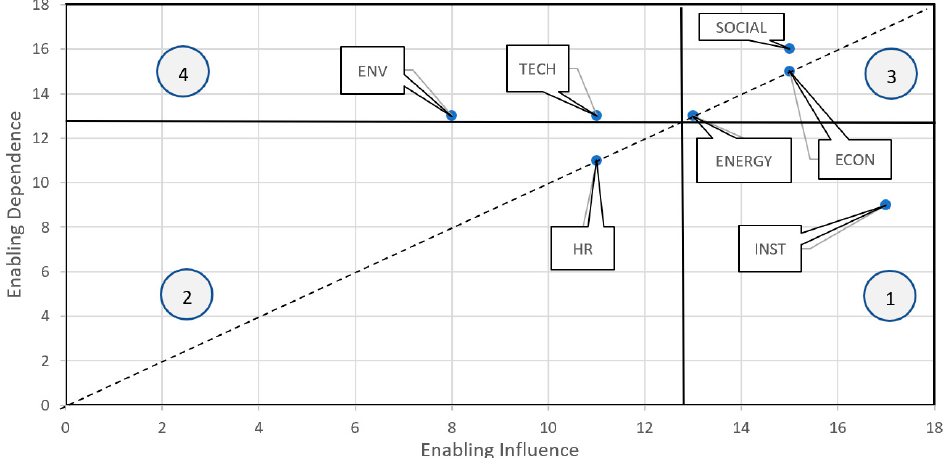
Figure 2. Graph showing the values of the degrees of direct net influence and dependence for all seven categories of capacity: INST (institutional); HR (human resources); TECH (Technical); ECON (Economic); ENERGY; ENV (Environmental); SOCIAL (social/cultural). The graph consists of four sectors defined by the average values (12.85) of the net influence and dependence of Table 4.